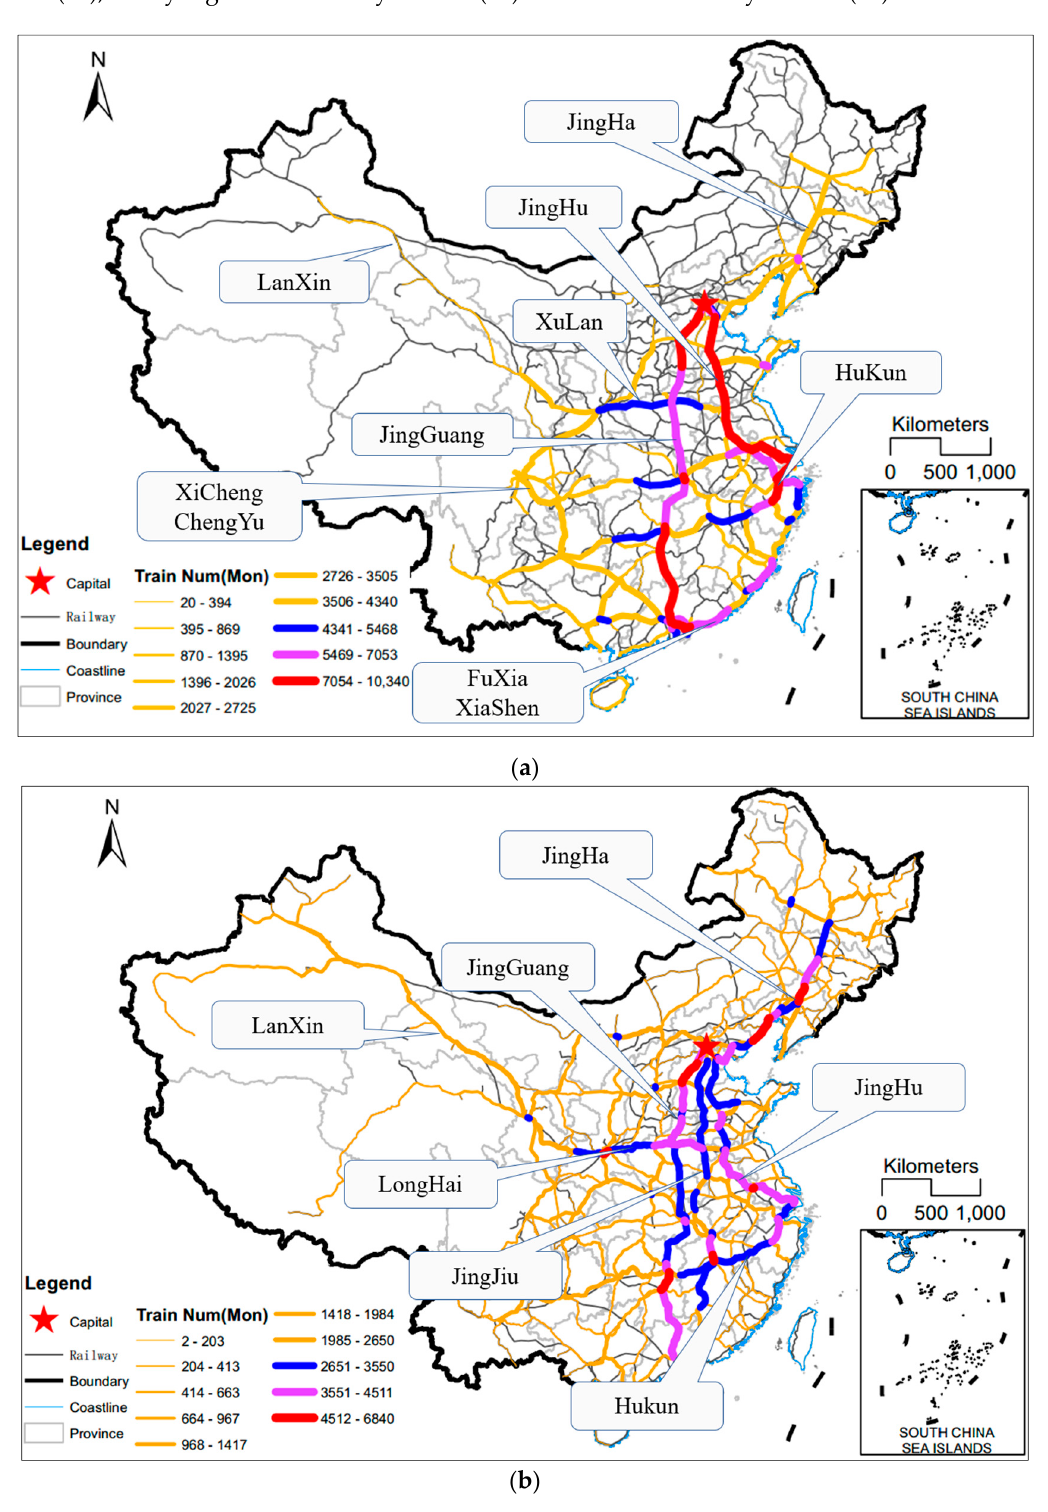
Figure 5. Spatial distribution of the geographic railway network. ( a ) The geographic network of high-speed railway. ( b ) The geographic network of normal-speed railway.